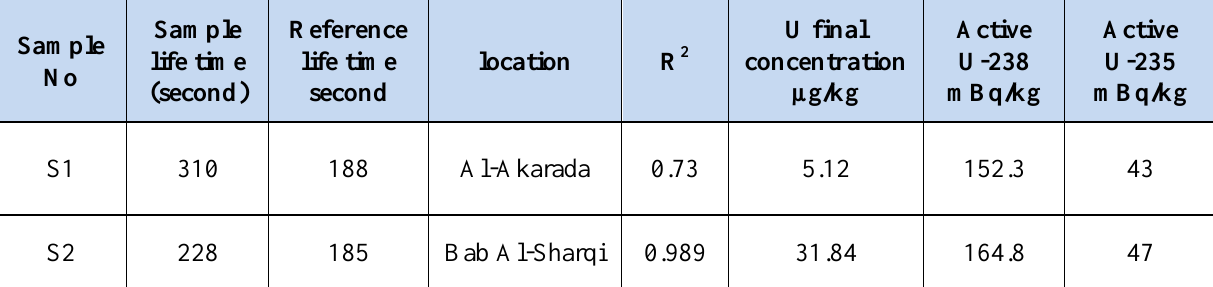
Table 1: The overall results of NORM of local soil samples taken from Tigris rivers –